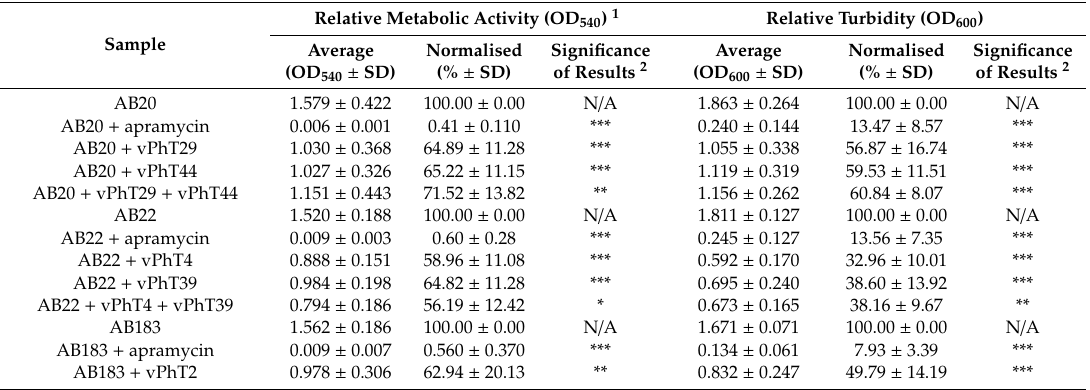
Table 2. Relative metabolic endpoint activity and turbidity of Acinetobacter baumannii samples treated for 24 h with bacteriophages or apramycin.